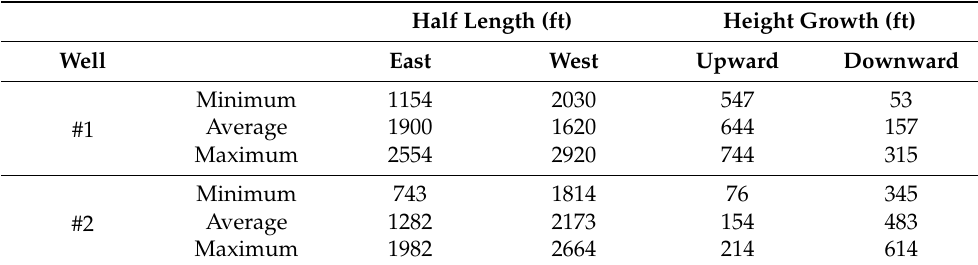
Table 3. Interpreted bulk geometry from microseismic